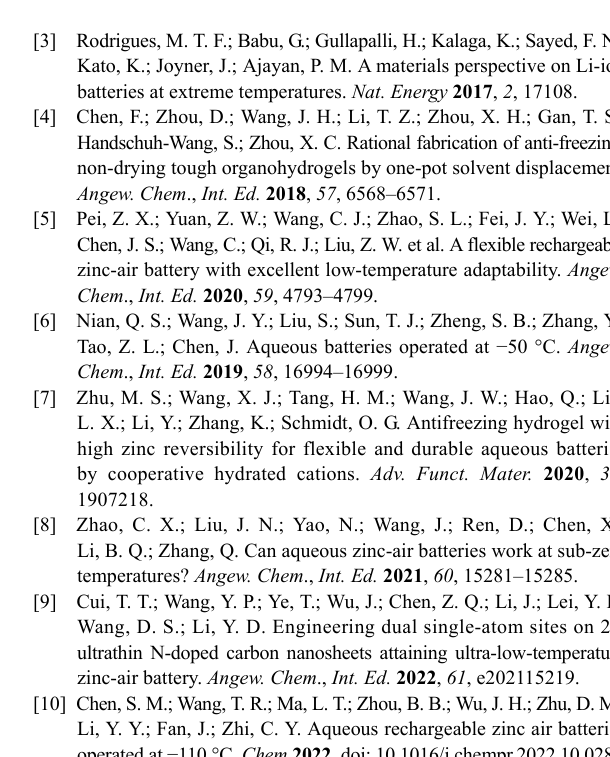
Figure 1 (a) The phase diagram of KOH solutions at various temperatures. (b) The schematic illustration of the ZAB using the cryogenic electrolyte and electrocatalyst. Reprinted with permission from Ref. [10], © Elsevier Inc.